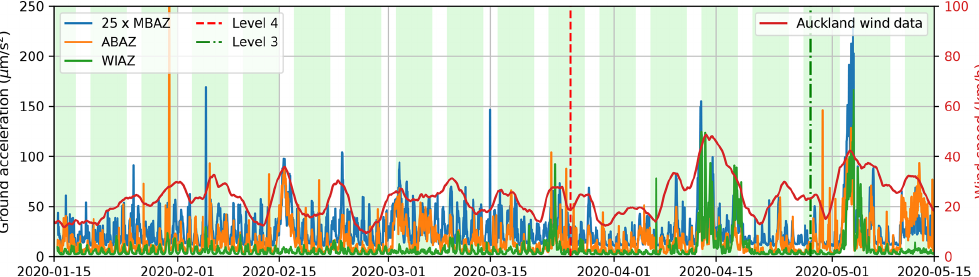
Figure 7. RSAM values for stations east of Auckland CBD, on the Hauraki Gulf. Only the borehole RSAM data from MBAZ, artificially multiplied by 25 for visual purposes, correlate with the Level-4 lockdown in New